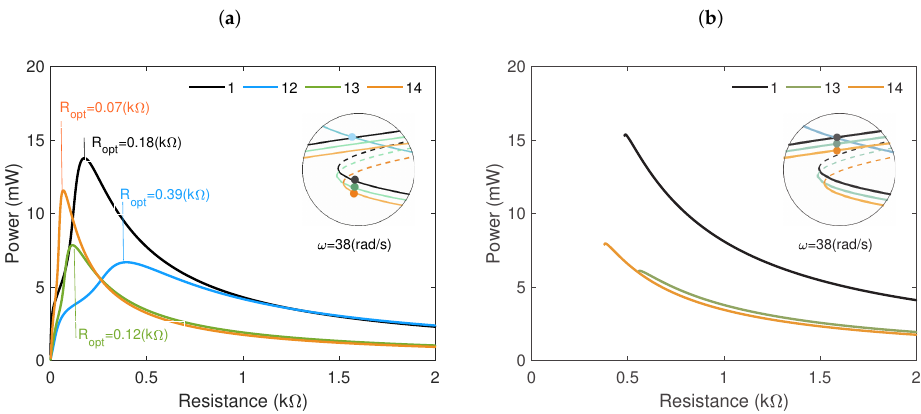
Figure 10. Output power was obtained for the solution from the bottom ( a ) and top ( b ) branches and a frequency of 38 rad/s. The power was calculated from equation P = max ( i 2 ( t )) R . Figure 11a,b show the maximal and minimal displacement of the levitating magnet versus resistance. After comparing both diagrams, it can be concluded that resistance does not influence the magnet’s displacement represented by the top branch (Figure 11b). For the bottom branch (Figure 11a), the resistance effect is visible for resistance lower than 0.5 k Ω